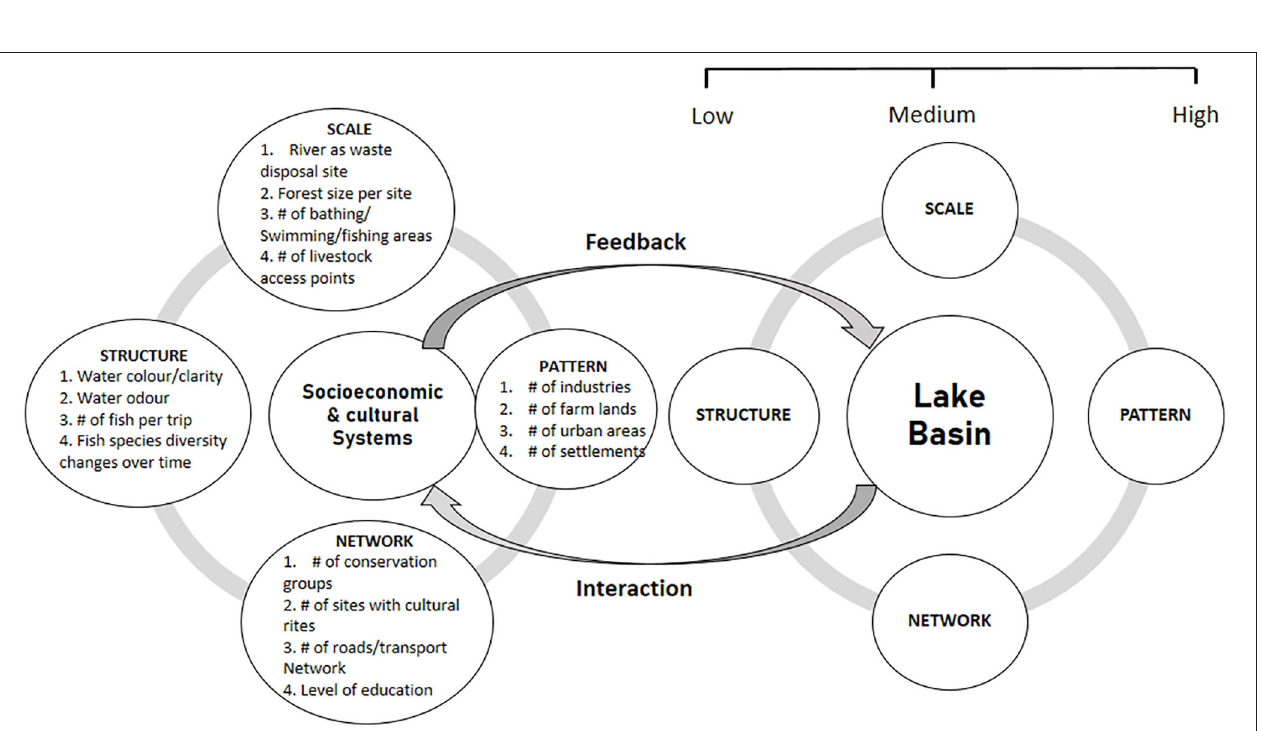
FIGURE 3 | Schematic representation of the socioeconomic and cultural metrics for the development of the Citizen Index of Ecological Integrity (CIEI) novelty for assessing the pollution status of major river catchments in Lake Victoria, Kenya.